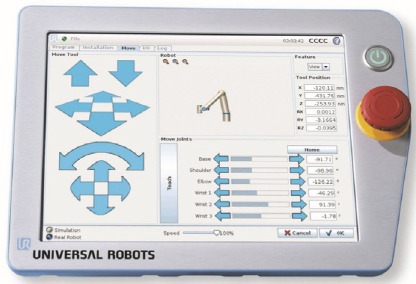
Figure 3: The Universal Robots teach